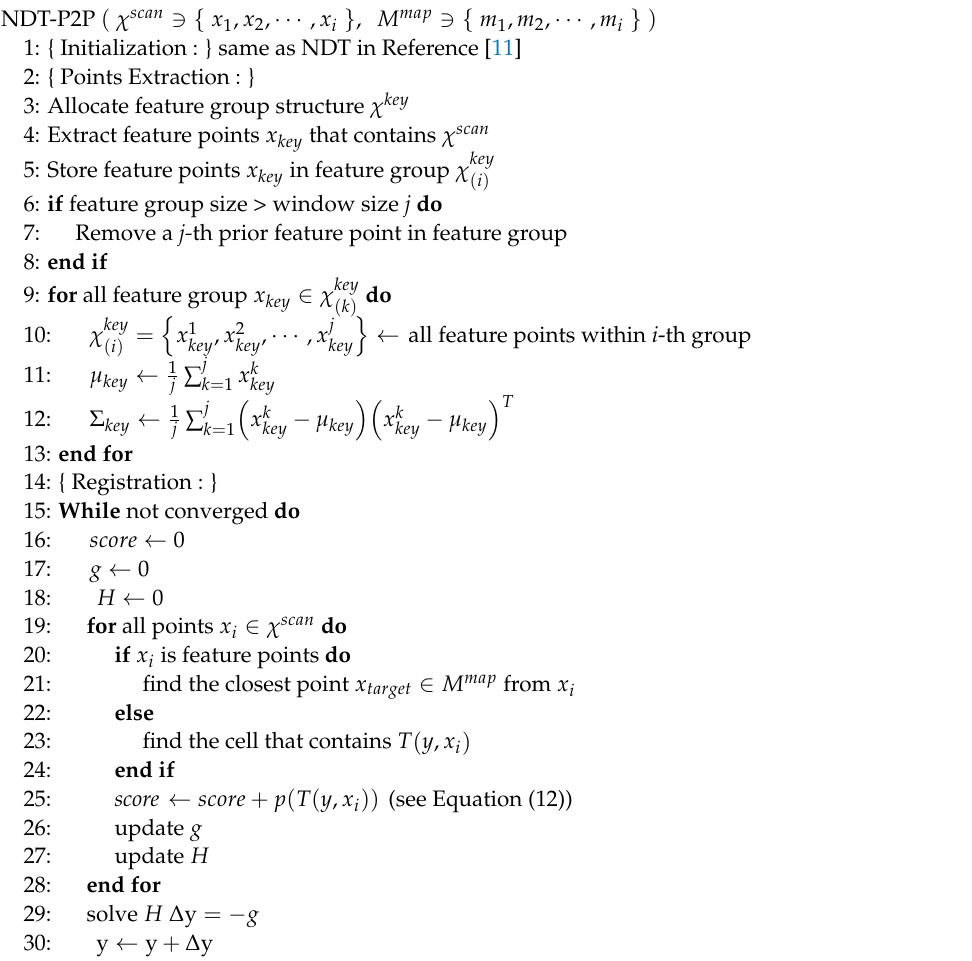
Algorithm 1. Register scan points χ scan to map M map using